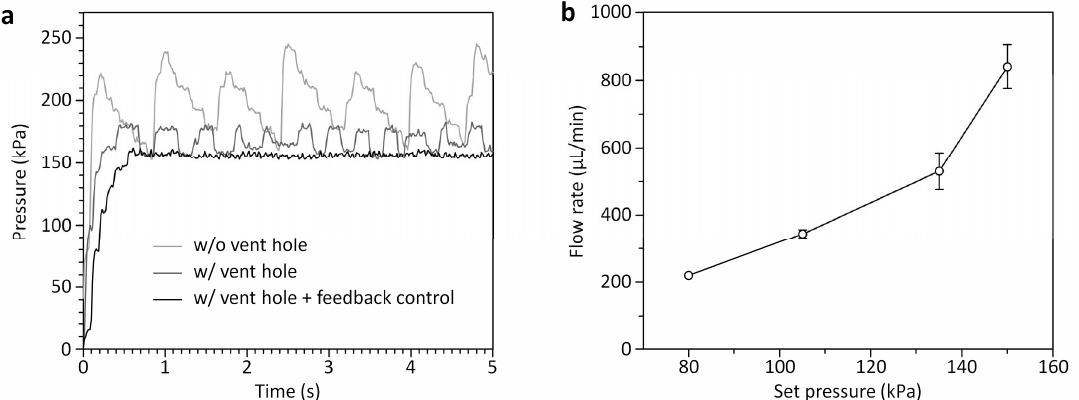
Figure 3. Pressure and flow-rate control using the smart pipette. ( a ) Pressure control responses to a step command for a set pressure of 150 kPa with a duty cycle of 55%. The combination of the vent hole and the feedback control allows stable pressure control with a CV of 1.2%. ( b ) Flow-rate control with set pressures. The flow rate presented here was calculated by dividing the blood volume injected during smart pipetting through the microfluidic cell concentrator by time. Error bars represent standard deviations ( n = 3).